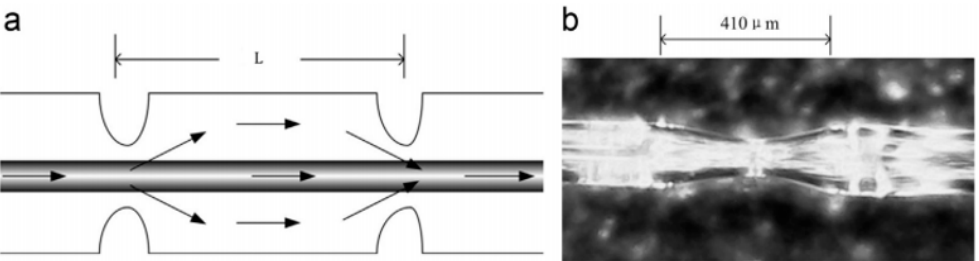
Figure 7. ( a ) Schematic diagram of the interferometer and ( b ) the microscope image of the taper.